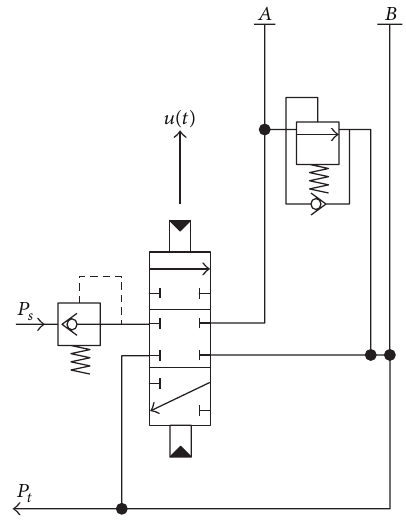
Figure4:Bidirectionalelectrohydraulicvalve.Theconfigurationfor the first link resembles a regenerative 2/3 setup, where the 𝐵 side is directly connected to the tank and the supplied oil is driven only to the 𝐴